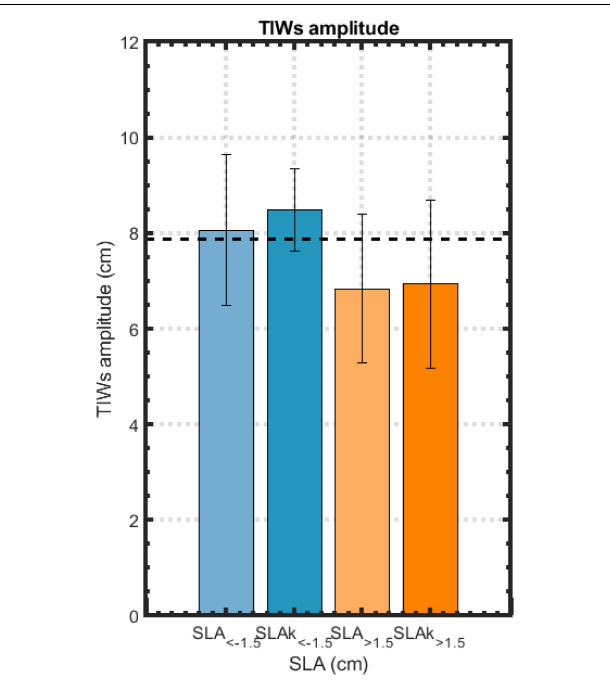
FIGURE 3 | Mean TIWs amplitude (calculated using the method described in Boucharel and Jin, 2020, applied on SLA reconstructed from CEOF1 + 2) during upwelling (blue) and downwelling (orange) events. Upwelling (Downwelling) events correspond to events identified in Figure 2A restricted to when the total sea level anomalies averaged in the region (2 ◦ S–2 ◦ N, 150–80 ◦ W) are below − 1.5 cm (above + 1.5 cm). Similarly, the dark blue and orange bars represent the average TIWs amplitude for upwelling (downwelling) events when the total sea level anomalies projected on the Kelvin wave mode (SLAk) are below − 1.5 cm (above + 1.5 cm). The error bars represent ± 1 standard deviation of TIWs amplitude amongst the retained events. The dashed black horizontal line indicates the annual mean of TIWs amplitude calculated from the method by Boucharel and Jin (2020) applied on the total sea